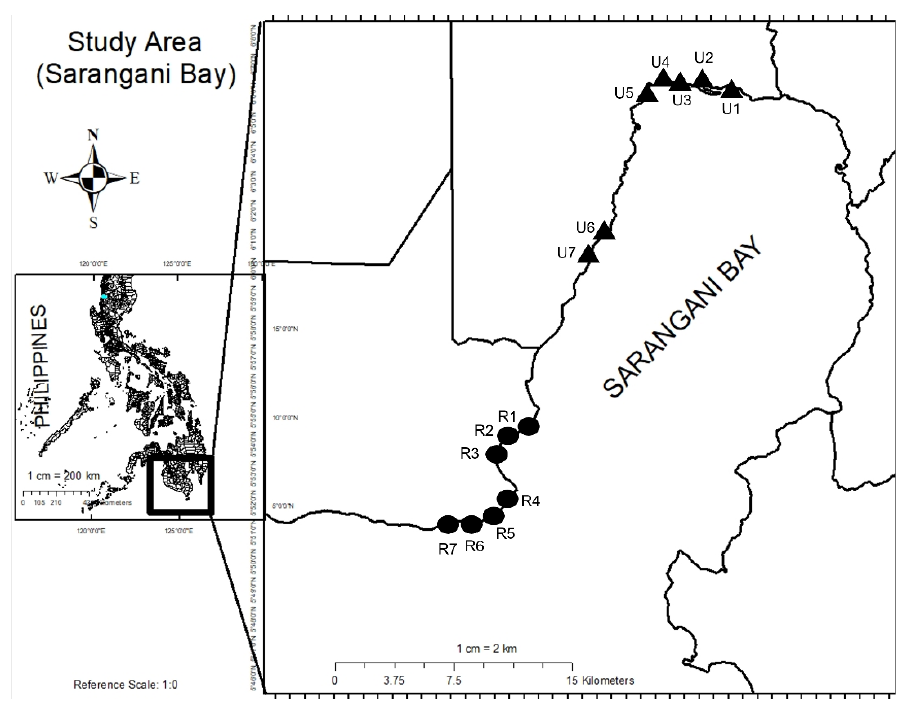
Figure 1. The map of Sarangani Bay bounded by Sarangani Province and the chartered city of General Santos showing the sampling sites in urban (triangle) and rural (circle) areas. Table 1. Description of the study sites and macroplastics sampled from the beaches of Sarangani Bay, Philippines; SD — represents standard deviation of the replicates.